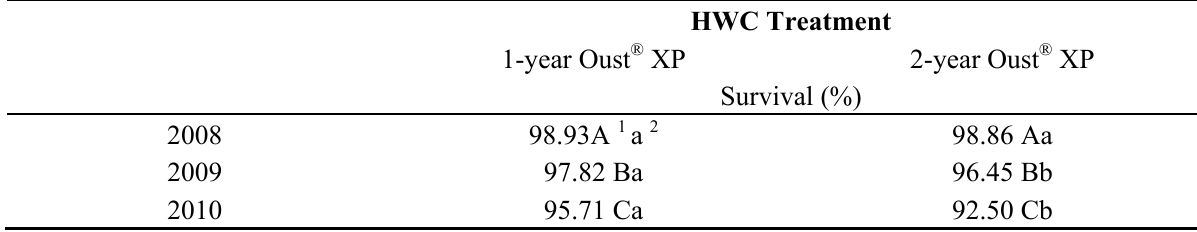
Table 2. Oak seedling survival by growing season and HWC treatment planted on three Mississippi sites,